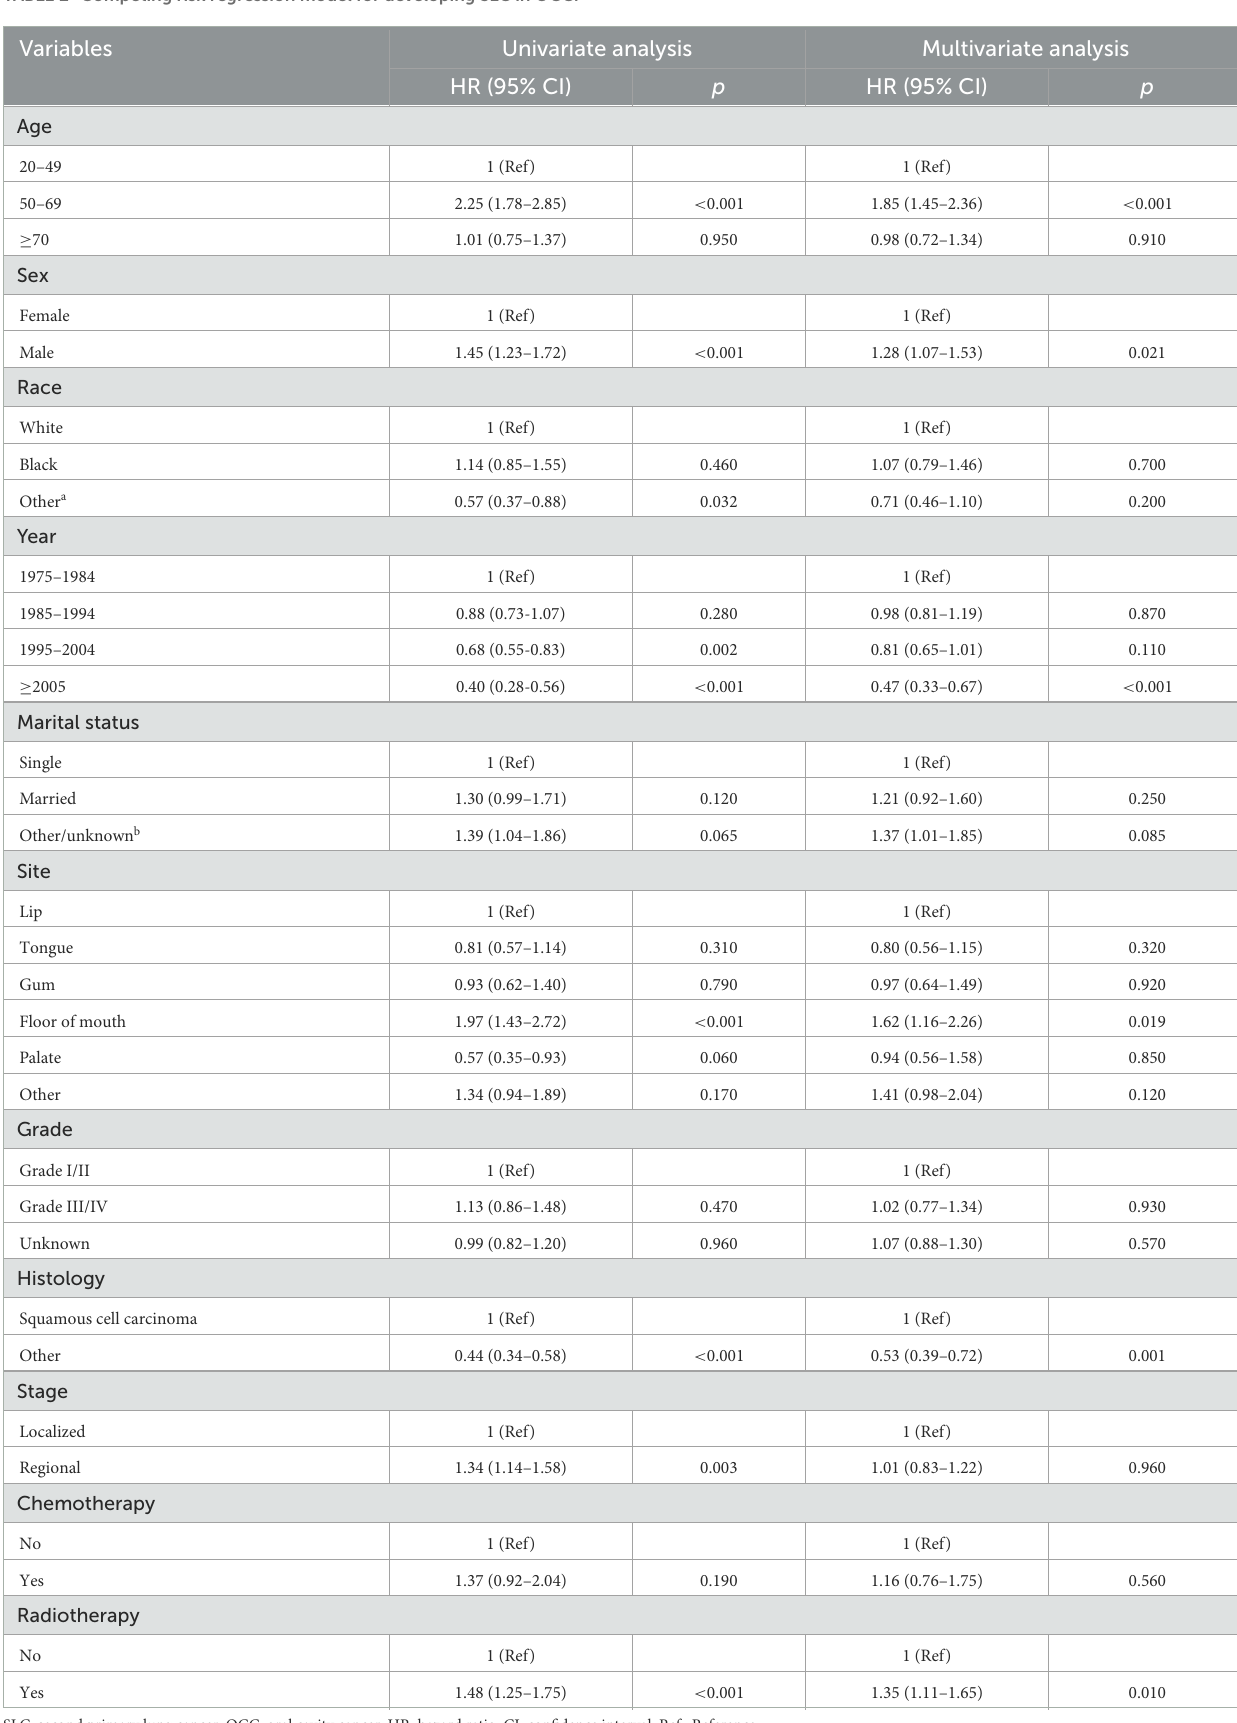
TABLE 2 Competing risk regression model for developing SLC in